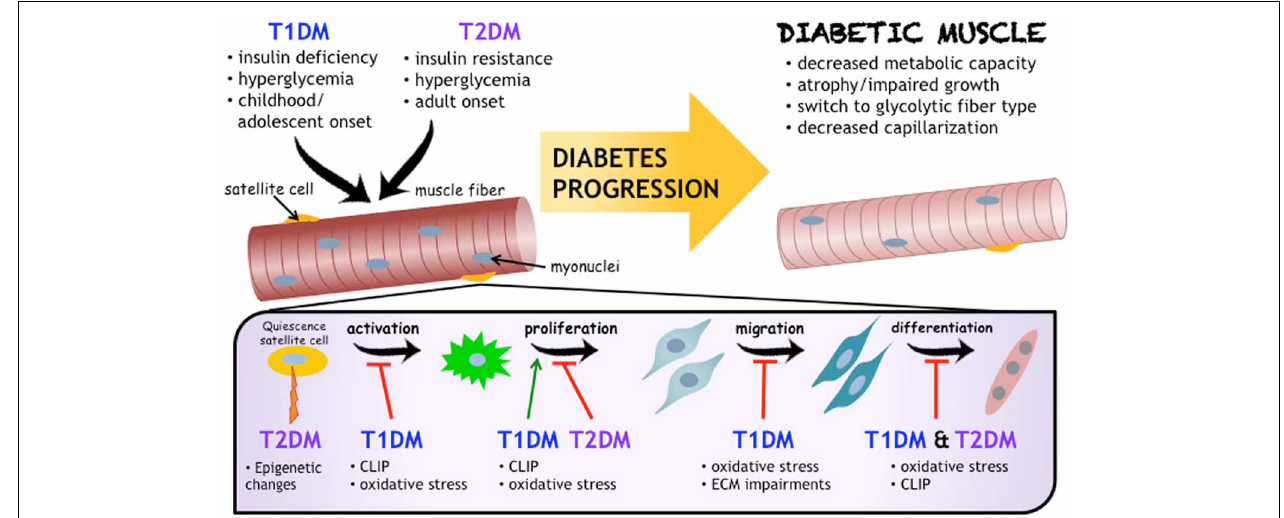
FIGURE 1 | Impact of Diabetes Mellitus on Skeletal Muscle Health. While the etiology and progression for T1DM and T2DM development are distinct, both diseases negatively influence skeletal muscle (referred to as “Diabetic Muscle”) and their resident progenitor cell populations, including satellite cells. Satellite cells are critical to muscle health, and are affected by diabetes mellitus at varying stages of adult myogenesis.